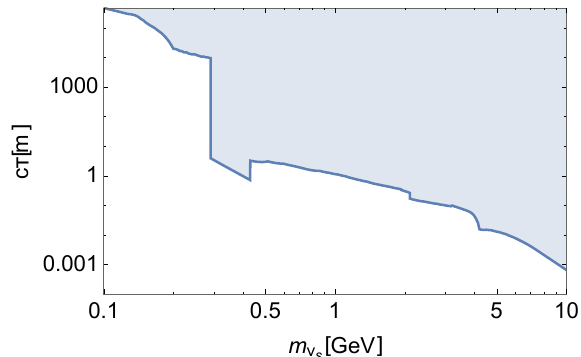
Figure 2 . Expected lower bounds on the length of (cid:13)ight ( L (cid:13)ight of the heavy sterile neutrino mass (in GeV), assuming the maximal allowed mixings with the light active